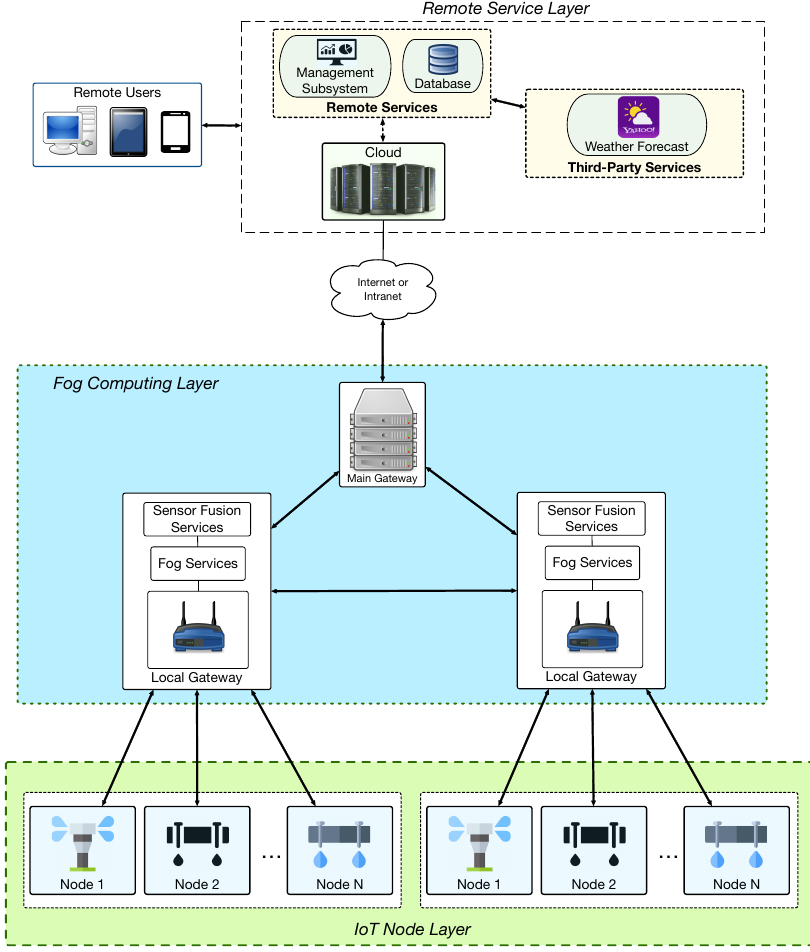
Figure 3. Designed communications architecture of the proposed